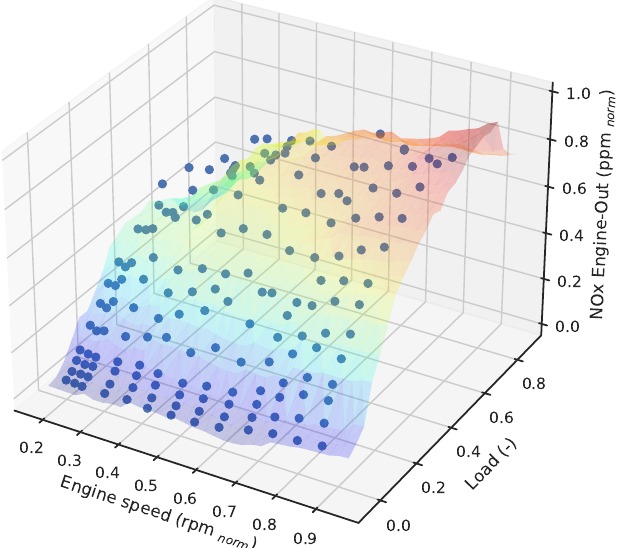
Figure 16. Three-dimensional comparison between experimental and modeled NOx emissions under steady-state conditions. Experimental values are represented by the scatter points; model prediction is represented by the